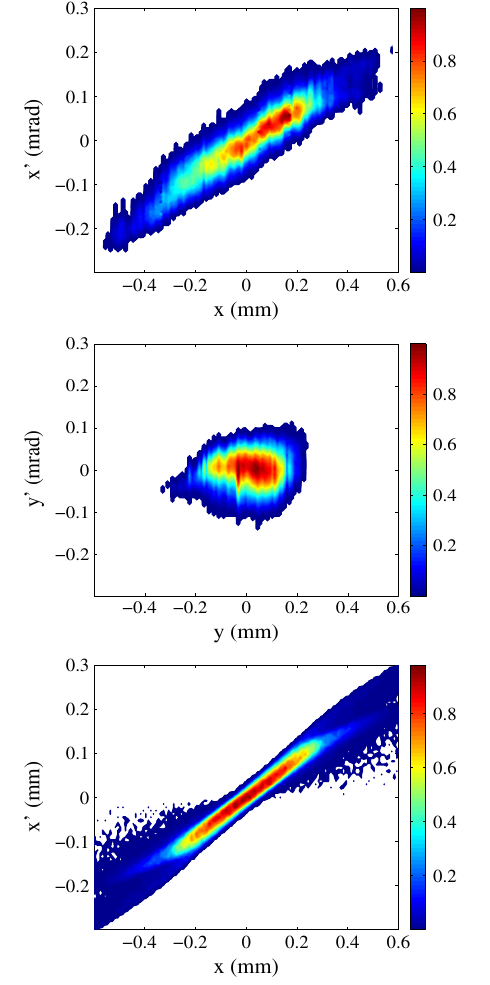
FIG. 25. Measured horizontal (upper plot), vertical (middle plot), and simulated horizontal phase space (bottom plot) for a bunch charge of 0.1 nC. Because of perfect x - y symmetry assumed in simulations, the simulated vertical phase space is identical to the horizontal one.